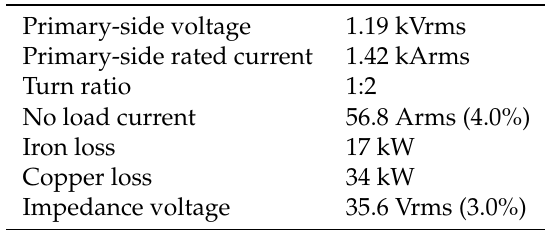
Table 3. Data for the matching transformers (MTs) used in Figure